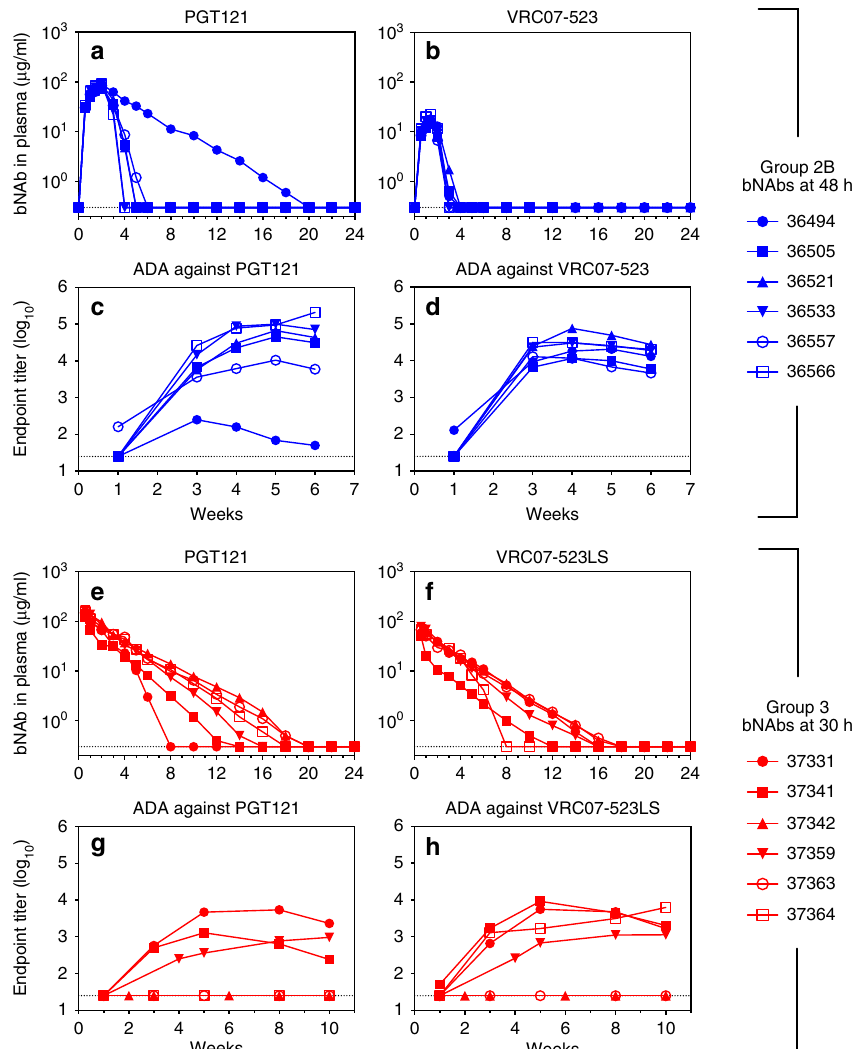
Fig. 3 Pharmacokinetics of bNAb treatments. a , b Plasma concentrations of PGT121 and VRC07-523 in Group 2B animals (5 mg/kg each bNAb at 48 h and on days 4, 7, and 10). Except for 36494, no animal had detectable PGT121 or VRC07-523 in plasma after week 6. c , d Endogenous anti-drug antibody (ADA) responses against passively administered bNAbs for Group 2B animals. e , f Plasma concentrations of PGT121 and VRC07-523LS in Group 3 animals (20 mg/kg each bNAb at 30 h). g , h Endogenous ADA responses against passively administered bNAbs for Group 3 animals. Concentrations of each bNAb were measured by ELISA using binding to ST0A9 (PGT121) or RSC3 (VRC07-523 and VRC07-523LS). Dotted lines indicate limits of detection. Group colors and individual animal symbols are consistent throughout the manuscript. Source data are provided as a Source Data fi